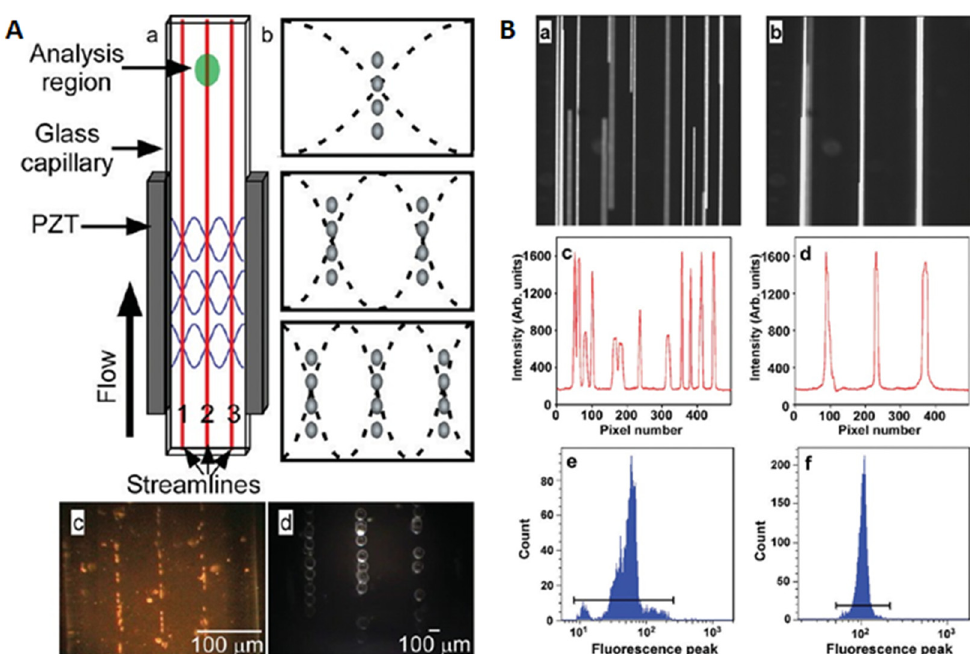
Figure 3. Multinode ultrasonic microparticle alignment in a rectangular cross-section glass capillary. ( A ) shows a schematic drawing of the device ( a ), the principle of particle alignment ( b ), and the alignments of 10 µ m particles in a w × h = 1 × 0.1 mm capillary ( c ) and 107 µ m polystyrene particles in a 2 × 0.2 mm capillary ( d ). ( B ) analyses of multinode acoustic particle alignment in a 1 × 0.1 mm glass capillary were presented. Reprinted with permission from [42] .